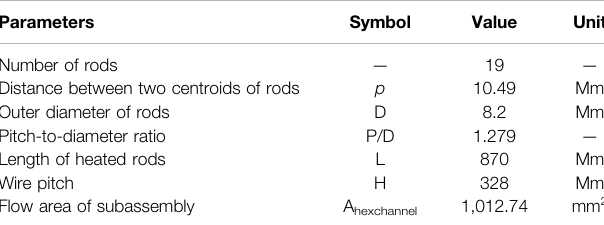
TABLE 1 | Some detailed parameters of the subassembly in the present study (Pacio et al., 2016).